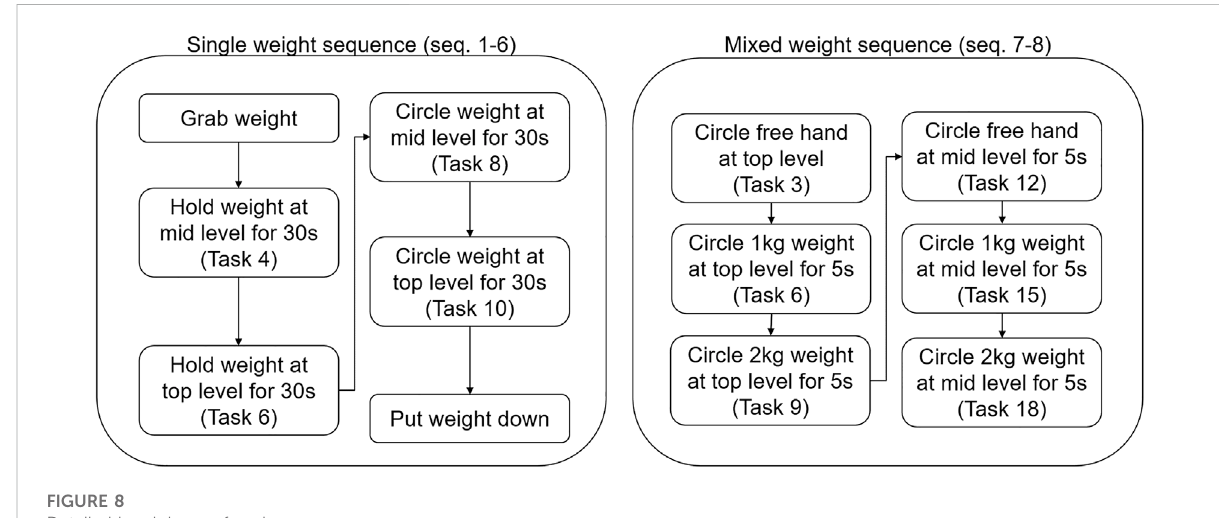
FIGURE 8 Detailed breakdown of each